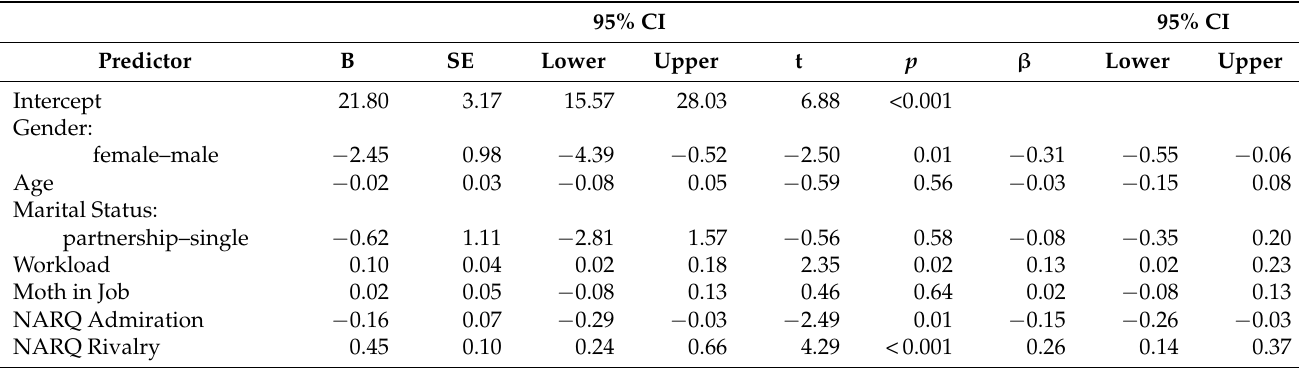
Table 5. Linear Regression Analysis for Emotional Exhaustion.